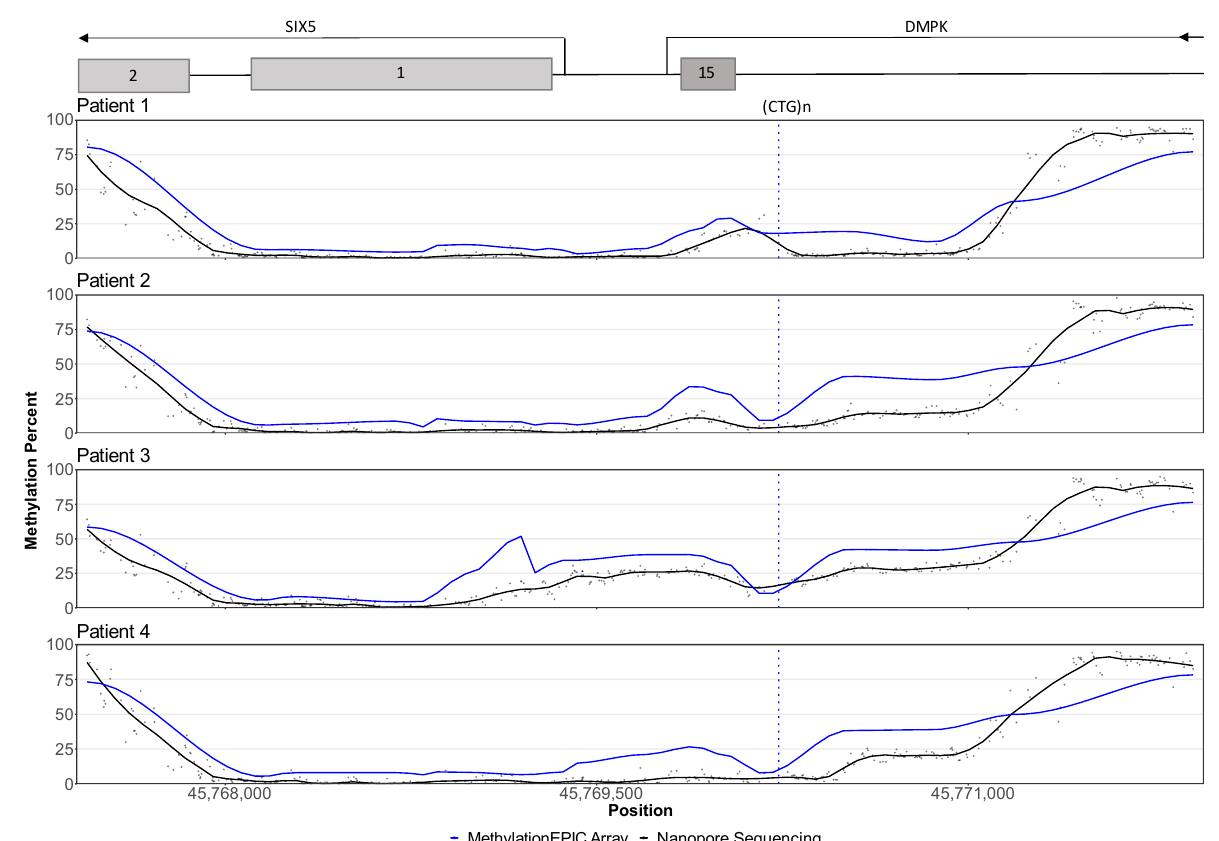
Figure 4. CpG methylation profiles of the patients. EPIC array data (blue lines) from 22 CpG sites is compared to nanopore raw data from 400 CpG sites (black points) and nanopore smoothed data (black lines). The y-axis represents the methylation level in percent and the x-axis represents the genomic position. The position of the CTG repeat is marked with a vertical blue stippled line and the approximate positions of nearby genes are indicated at the top of the plot. Patients 2 and 3 show hypermethylation both upstream and downstream of the repeat. In patient 1, hypermethylation is seen downstream of the repeat, while the methylation levels upstream of the repeat are less clear. Patient 4 has an opposite pattern of patient 1, with clear upstream hypermethylation and possible hypermethylation downstream of the repeat. The methylation patterns observed with EPIC arrays and nanopore sequencing are similar, although nanopore data show lower methylation levels around the repeat, and higher levels towards the upstream end of the CpG